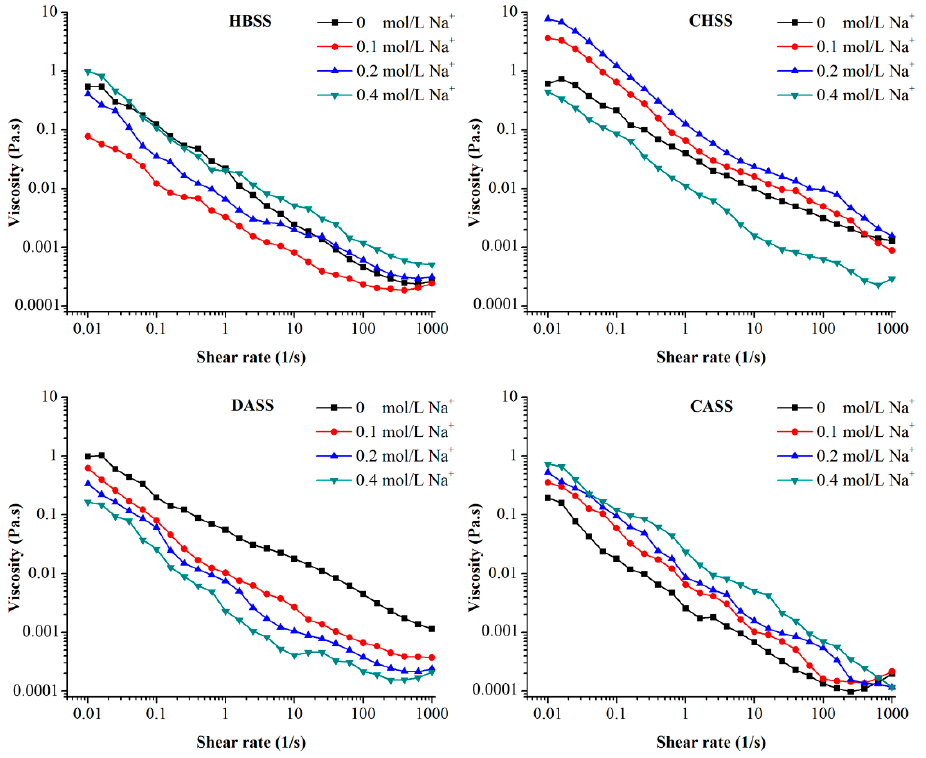
Figure 6. Variation of apparent viscosity of 1% MLPs with addition of different concentrations of NaCl at 20 °C.